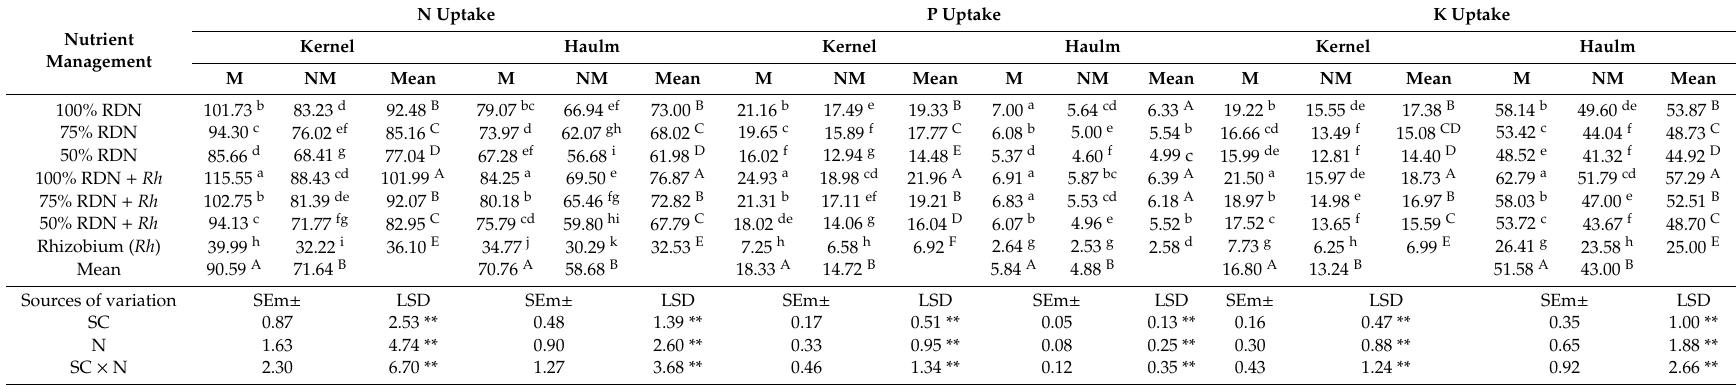
Table 4. E ff ect of soil covering and nutrient management on Nitrogen (N), Phosphorus (P) and Potassium (K) uptake in di ff erent plant parts of peanut in 2015–2016. Nutrient Management